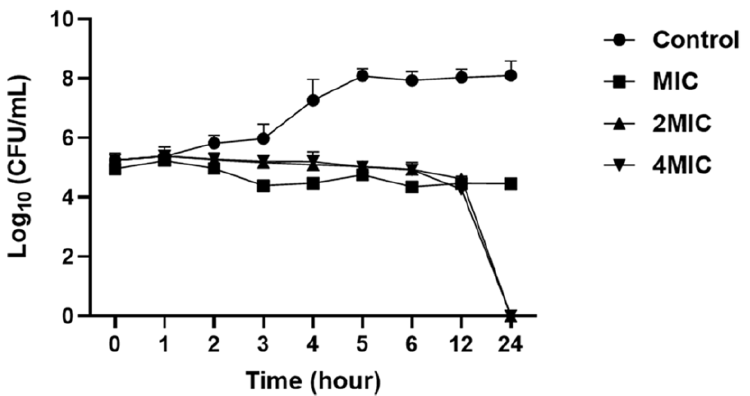
Figure 4. Time-kill curve of L. monocytogenes after treatment with COS-EGCG conjugate at different concentrations, as well as the control with 0.01% acetic acid in the TSB medium. The results are presented as means ± SD ( n = 3) .